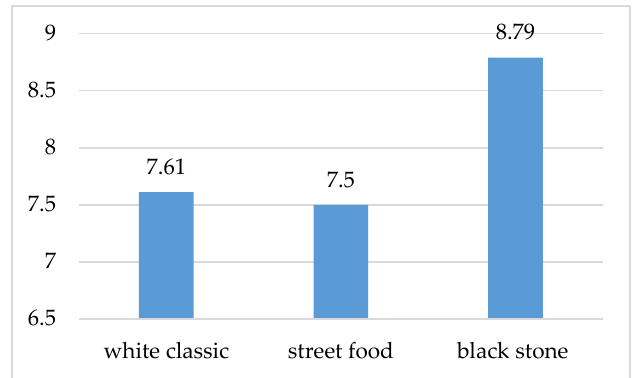
Figure 5. Conscious evaluation of the visual presentation of waffles served in three different ways.